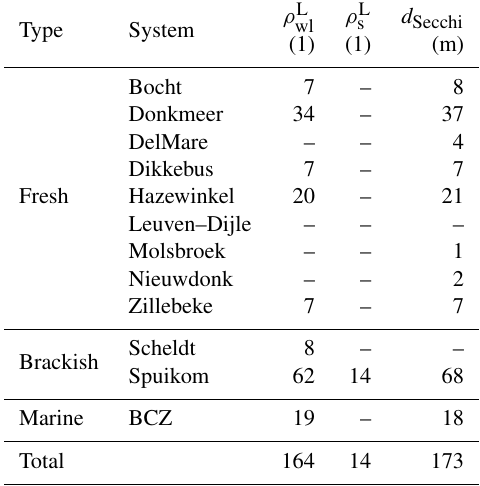
Table 4. Summary of measured apparent optical properties per wa- ter